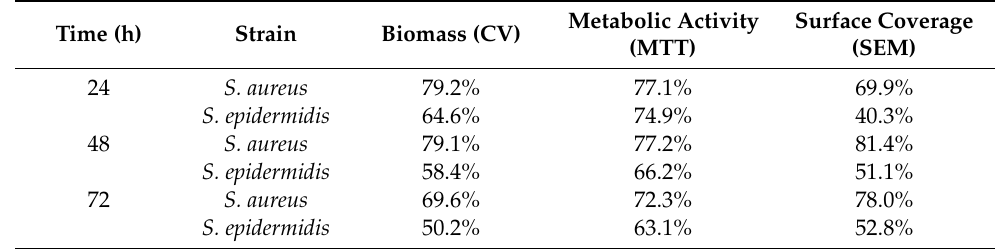
Table 3. Inhibition percentages of Staphylococcus spp. biofilm formation detected by CV and MTT assays. Relative inhibitions in the percentage of biofilm-covered surface obtained from SEM analysis are also reported.